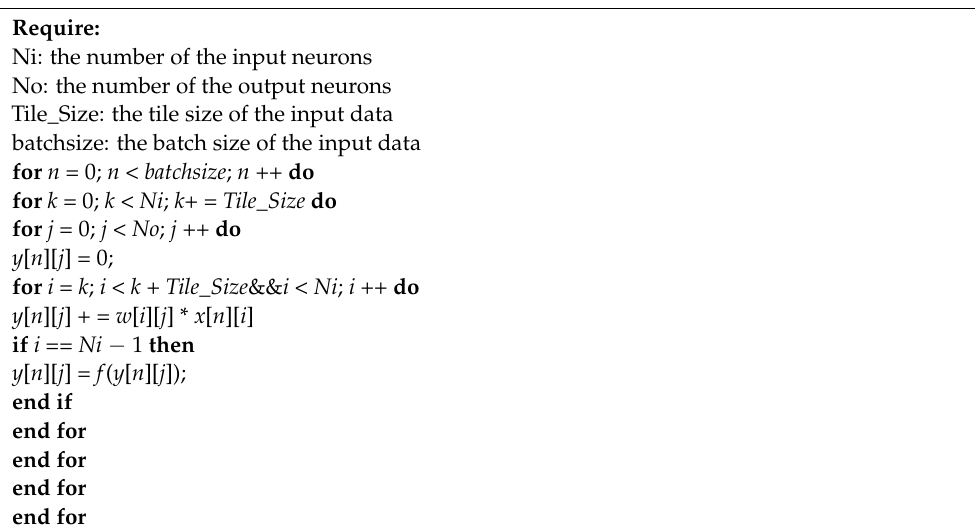
Algorithm 2 Pseudocode of the Tiling